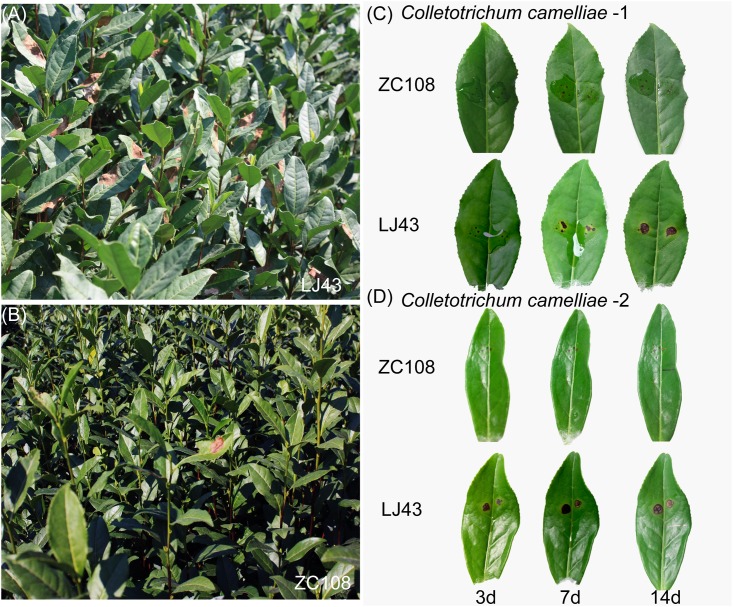
Altered disease resistance of tea leaves to AD in ZC108.(A, B) Leaf symptoms of LJ43 (A) and ZC108 (B) after suffering from AD in the field. (C, D) Differential disease resistance of tea leaves to Colletotrichum camelliae (1×105 ml-1) infection in LJ43 and ZC108. Two strains of Colletotrichum camelliae pathogens were used. Colletotrichum camelliae-1 and -2 were isolated from diseased tea plant leaves in Shaanxi and Zhejiang, respectively. Photos were taken on 3, 7 and 14 days post inoculation.